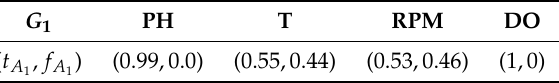
Figure 6. Vague graphs G 1 and G 2 . Table 2. Degree of vertices in vague graph G 1 .